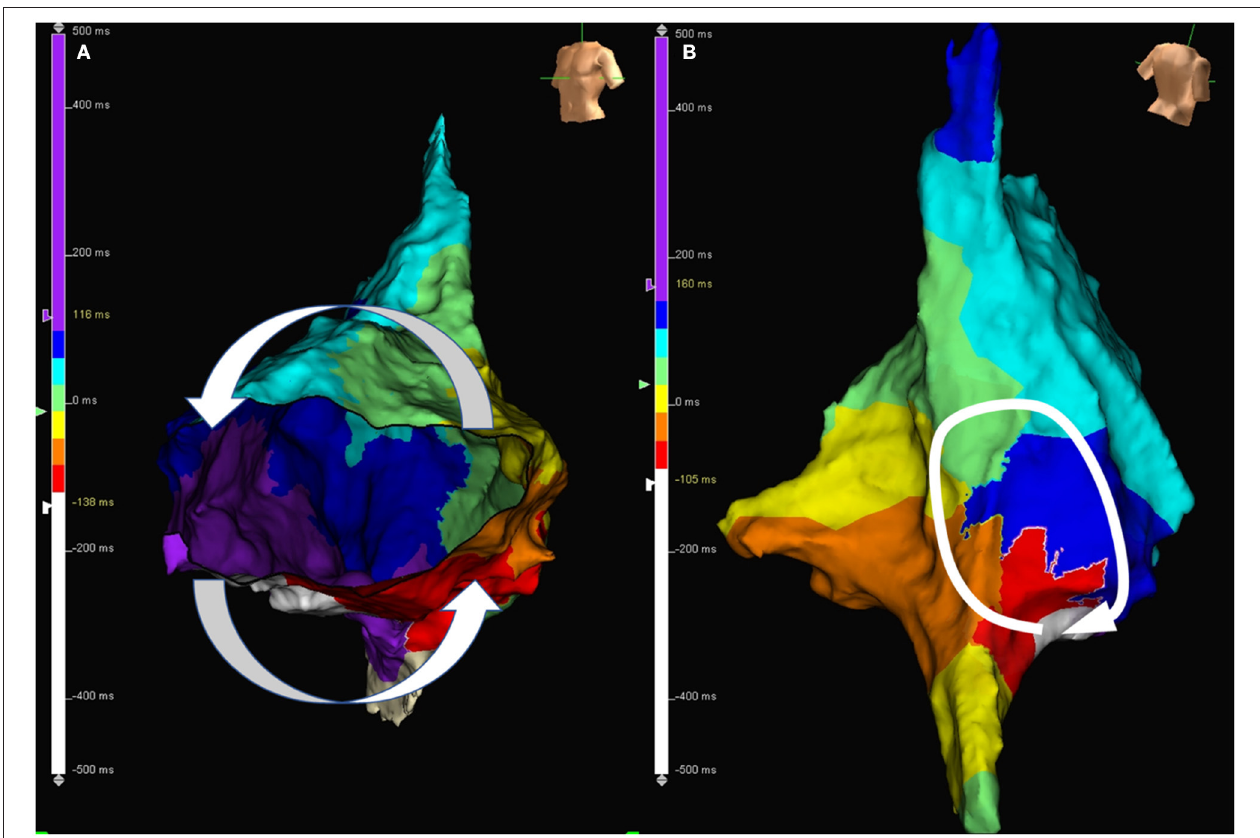
FIGURE 2 | (A) Activation map during AFL in a patient with typical AFL. The activation wave front travels through cavotricuspid isthmus and goes around the tricuspid annulus. (B) Activation map during atypical atrial flutter in a patient with atypical AFL. The activation wave front goes around the surgical scar located at the right posterior free wall. AFL, atrial flutter.